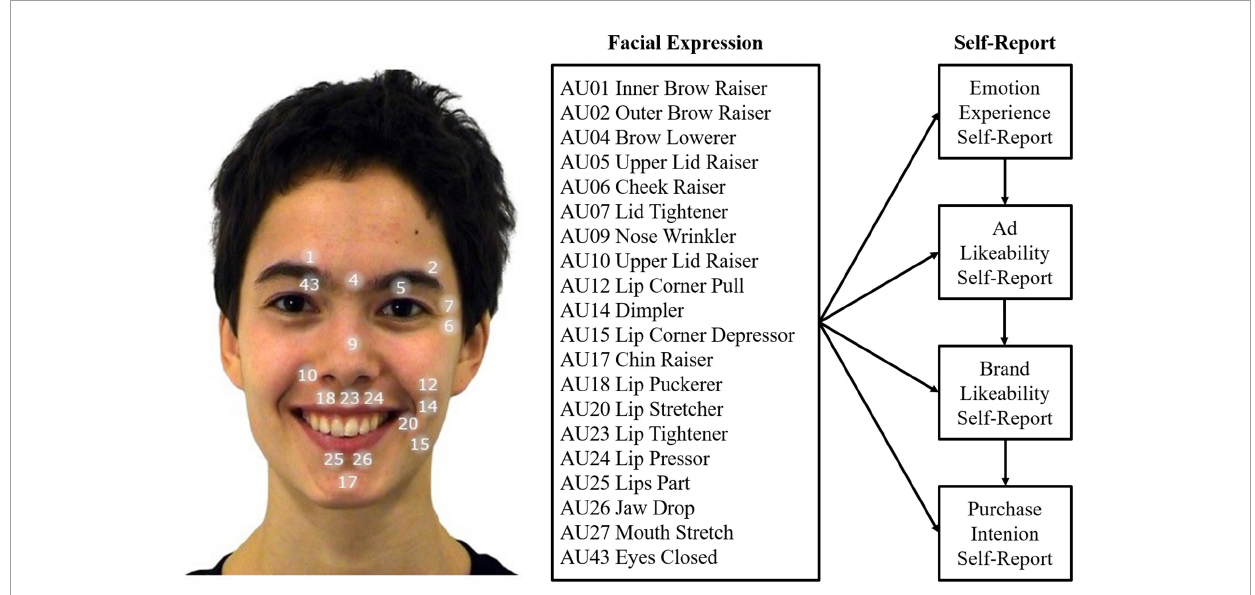
FIGURE1 Overview of the measured Action Units and hypothesized relations to self-report ratings. Depicted is a happy facial expression from the ADFES inventory (model F04; van der Schalk et al., 2011).